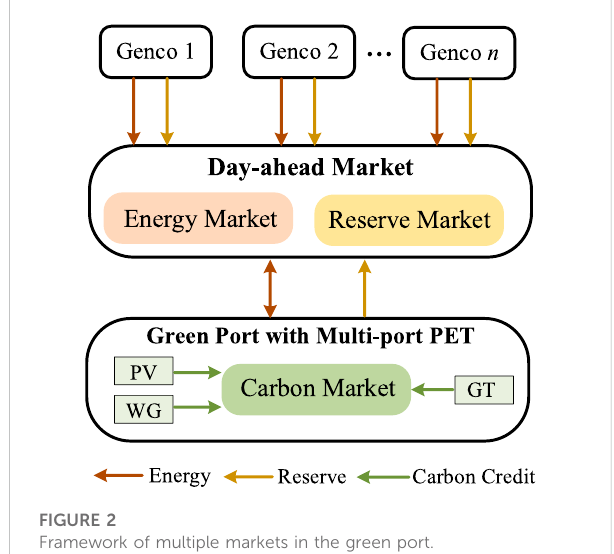
FIGURE 2 Framework of multiple markets in the green